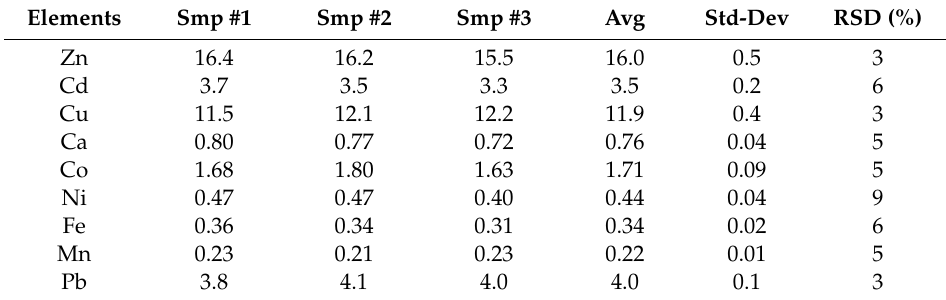
Table 4. Chemical assays (%) of three randomly selected feed samples (Smp = Sample; Avg = Average; Std-dev = Standard deviation RSD: = Std-Dev / Avg).